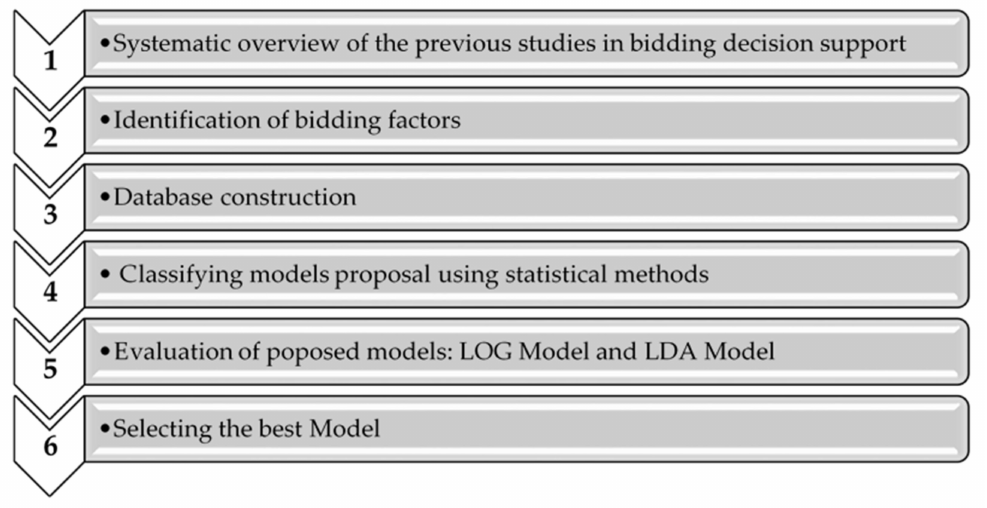
Figure 2. The research framework